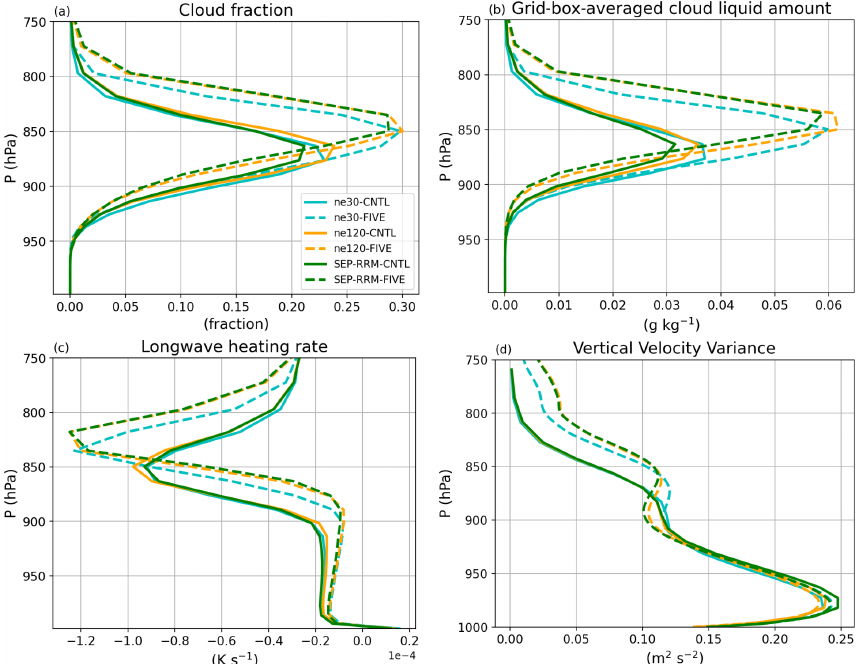
Figure 10. Profiles of (a) cloud fraction, (b) cloud liquid water, (c) longwave heating rate, and (d) vertical velocity variance predicted by CLUBB for each simulation averaged over 5 years. The profiles are spatially averaged over the domain used for regional refinement, as illustrated in Fig. 1. Only oceanic columns are included in the averages and are defined as those with a land fraction of less than 0.5.